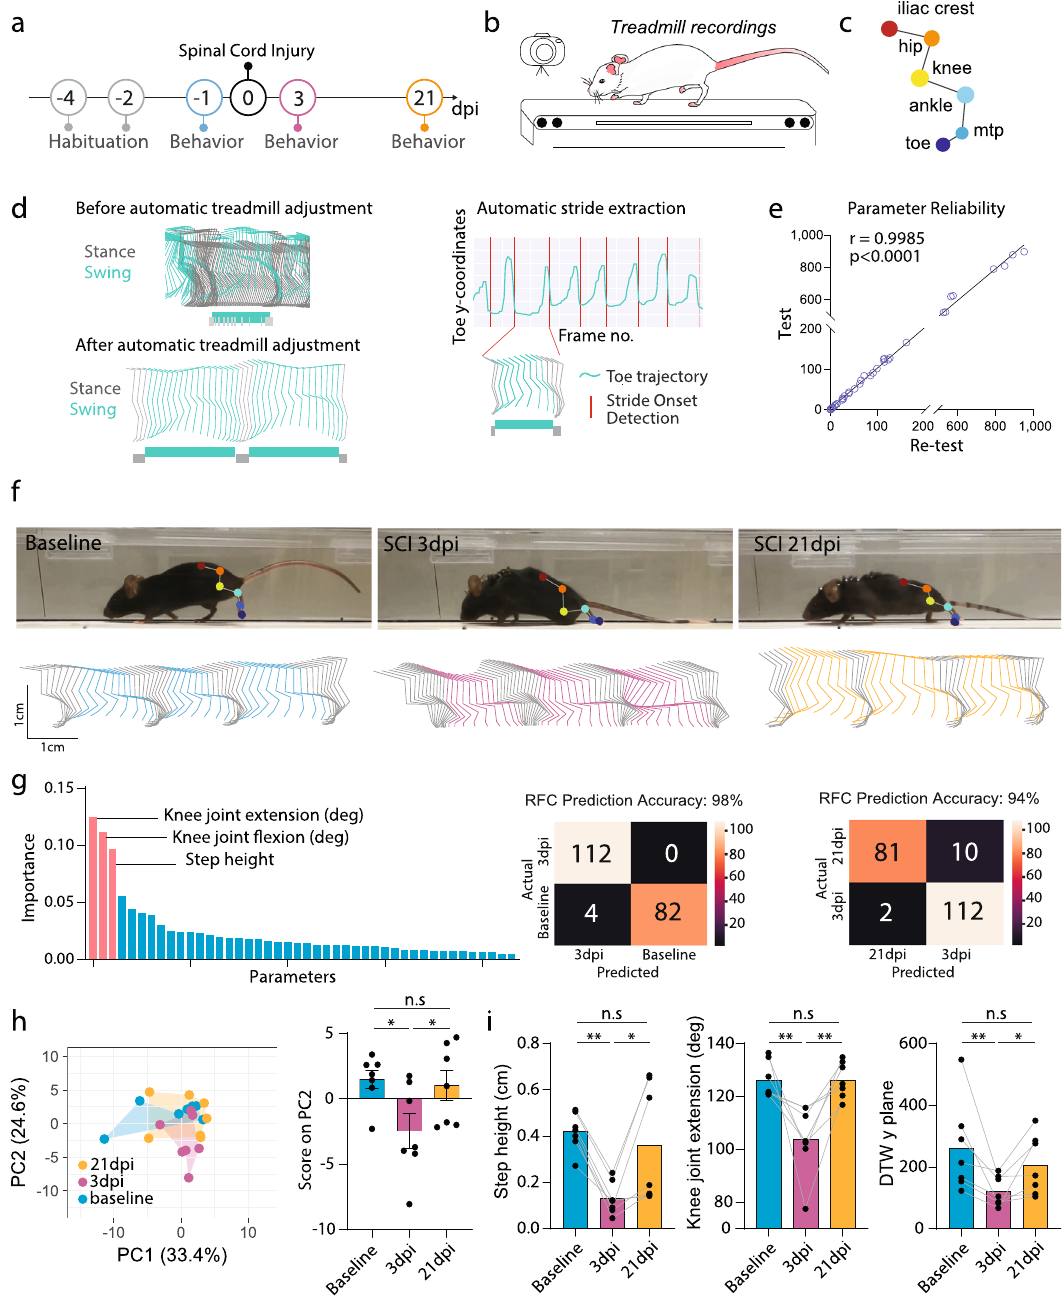
separately from those of the mice at baseline, while mice at 21 dpi of locomotor function (Fig. 2h). PC1 and PC2 together repre- between-group differences (Fig. 2h). After calculating the factor loadings, we identi fi ed three parameters that best-represented PC2 and were, thus, most likely to track SCI-related differences (Fig. 2h). Step height, knee joint extension, and dynamic time warping (DTW) demonstrated signi fi cant alterations at 3 dpi, and recovered over time until they were no longer signi fi cantly different from baseline (Fig. 2h and Supplementary Table